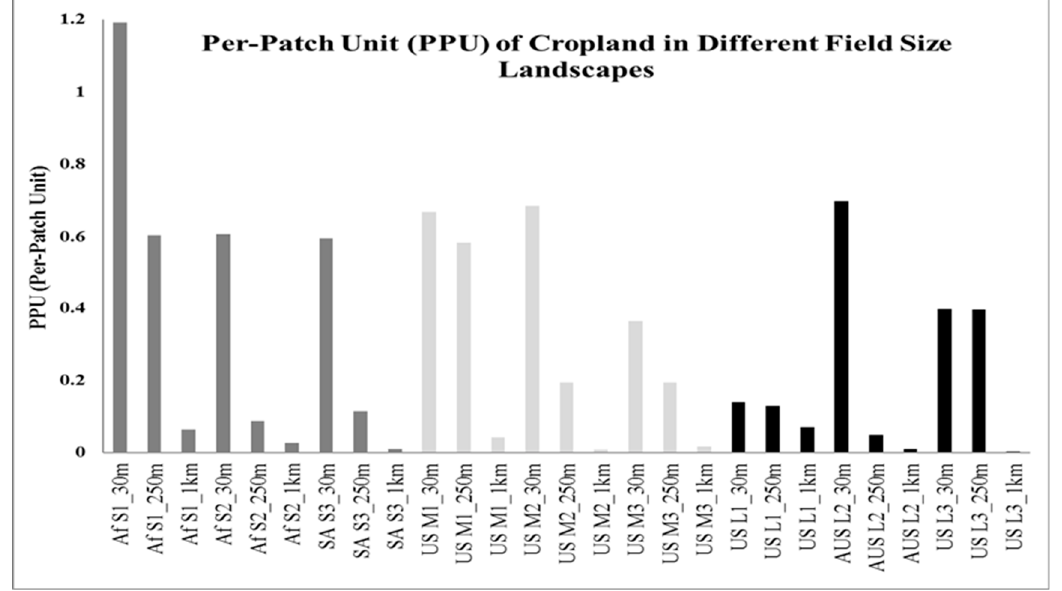
Figure 12. PPU Landscape heterogeneity of different-resolution maps in landscapes with different field sizes.